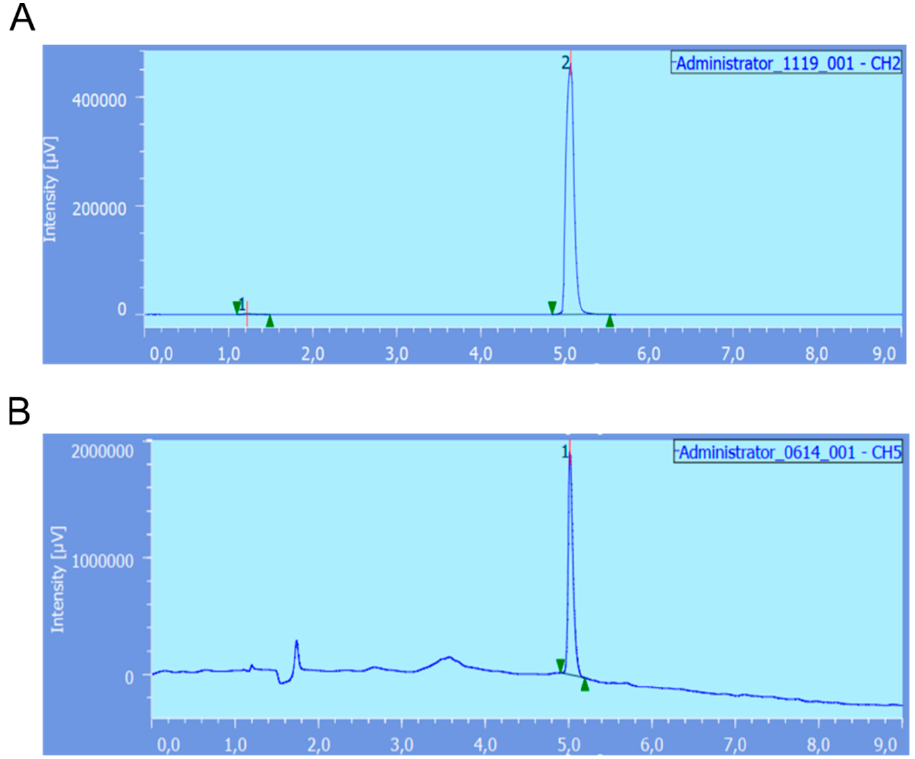
Figure 4. ( A ) radio-HPLC trace of [ 68 Ga]Ga-RM2 obtained after direct radiolabeling of the kit developed in this study. Chemical identity was checked using [ nat Ga]Ga-RM2 (UV-HPLC trace ( B )). Table 1. Validation batches of [ 68 Ga]Ga-RM2 obtained from the kit developed in this study.